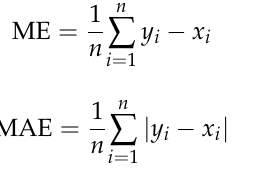
Figure 6. Box plot analysis for subject’s ( a ) SBP and ( b ) DBP distribution from the cuff device and proposed IPG-based system. Bland–Altman plot analysis in terms of ME for ( c ) SBP and ( d ) DBP, respectively. Estimation Error in terms of MAE for ( e ) SBP and ( f ) DBP.